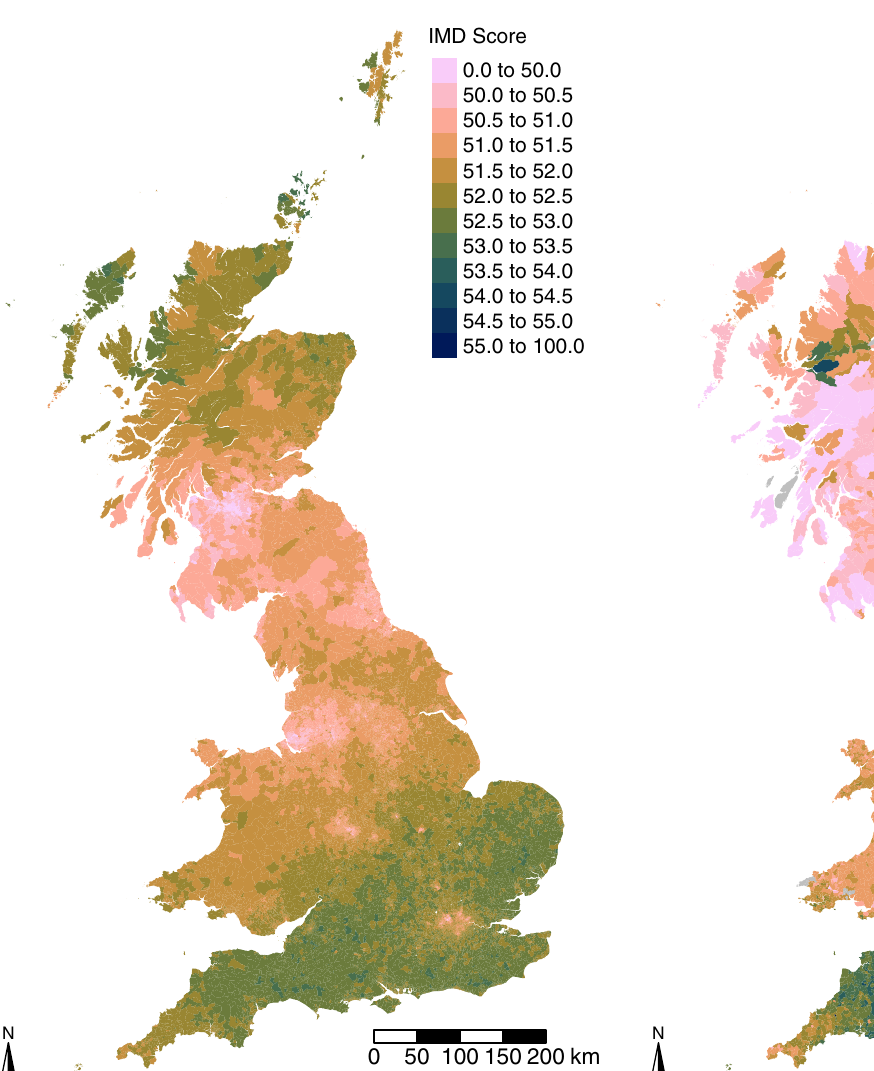
Fig. 4 Future Index of Multiple Deprivation (IMD) scores. 1851 modelled consistent parish IMD percentile scores, calculated as the average ‘ family IMD scores ’ of all residents from long-established family names. The map reveals a pronounced ‘ north – south divide ’ between the southwest of England and the rest of